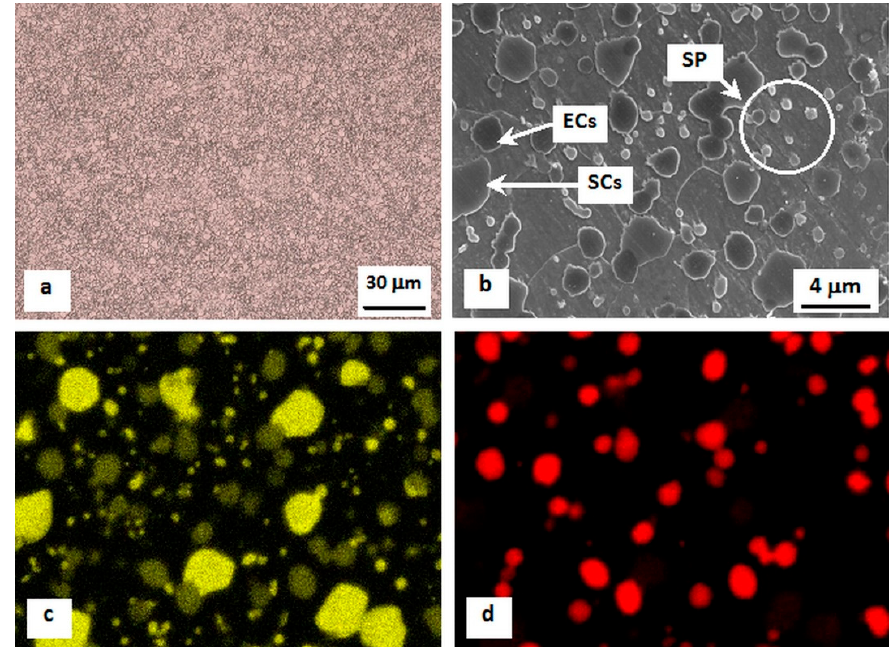
Figure 2. Microstructure of as-received steel: ( a ) optical micrograph, ( b ) SEM micrograph, and corresponding energy dispersive spectrometry (EDS) maps of ( c ) chromium and ( d ) vanadium.